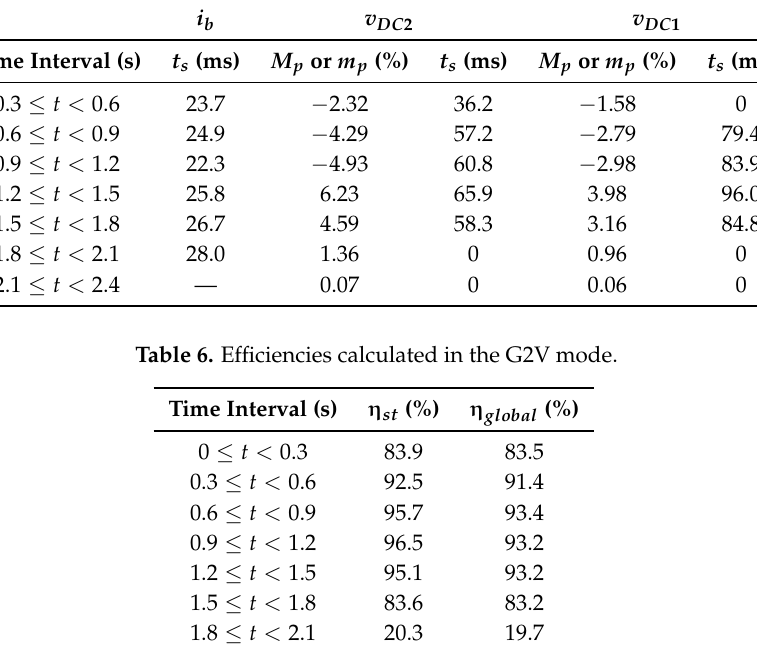
Table 5. Overshoot ( M p > 0) or undershoot ( m p < 0), and 2%-settling time ( t s ) in the G2V mode for i b , v DC 2 , and v DC 1 .